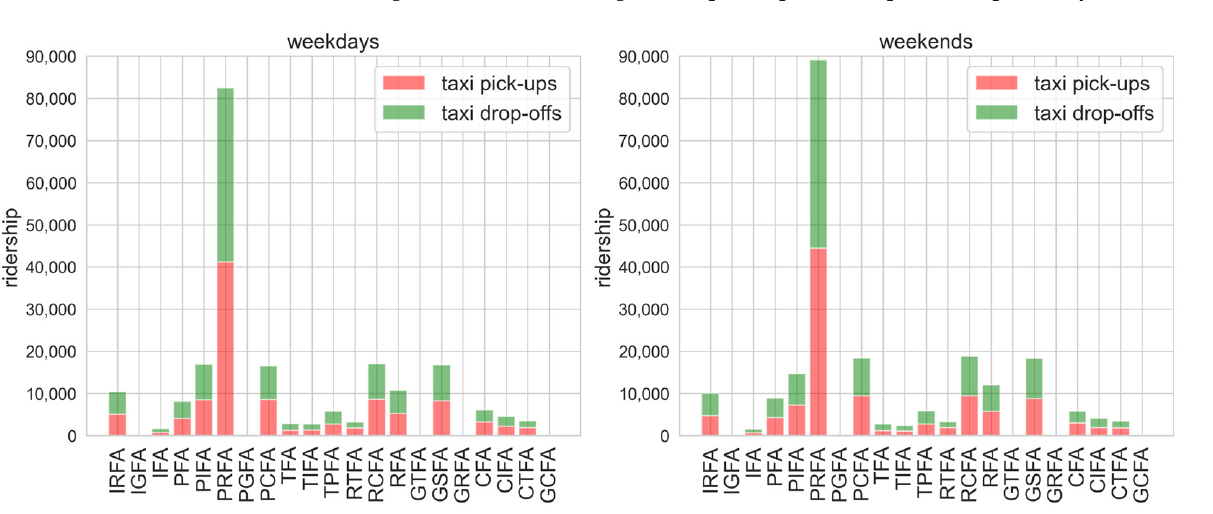
Figure 4. Daily average travel volume of each UFA type on weekdays and weekends.